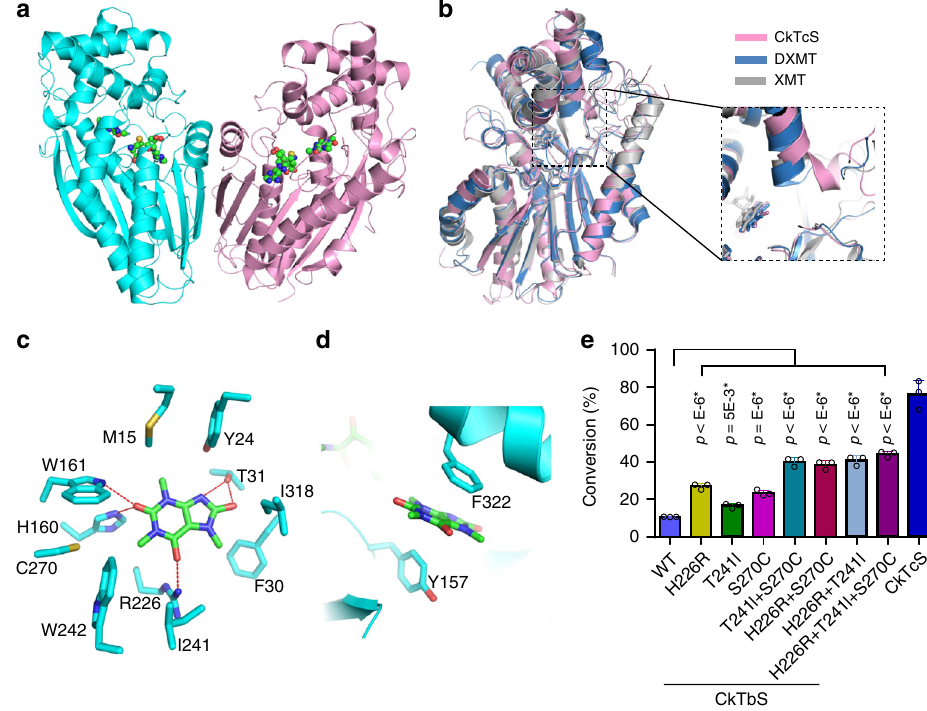
Fig. 4 Crystal structure of CkTcS. a Crystal structure of CkTcS dimer. SAH and 1,3,7-trimethyluric acid ( 5 ) are shown in ball-and-stick representation. b Structural overlap of CkTcS (pink) with DXMT (blue) and XMT (grey), with the major structural difference around the substrate binding pocket between CkTcS, DXMT, and XMT highlighted. c A close-up view of the CkTcS-1,3,7-trimethyluric acid interactions. The hydrogen bonds are shown in red dashed lines. d A close-up view of the π – π -stacking interactions. e In vitro methylation assay of wild-type (WT) or mutants of CkTbS using 1,3,7-trimethyluric acid as substrate, with CkTcS as positive control. Data represent mean ± SD ( n = 3). The corresponding dot plots are overlaid on the fi gure. The experiment was repeated twice. Differences were assessed statistically by two-tailed Student ’ s t -test, **** P < 0.0001, * P <